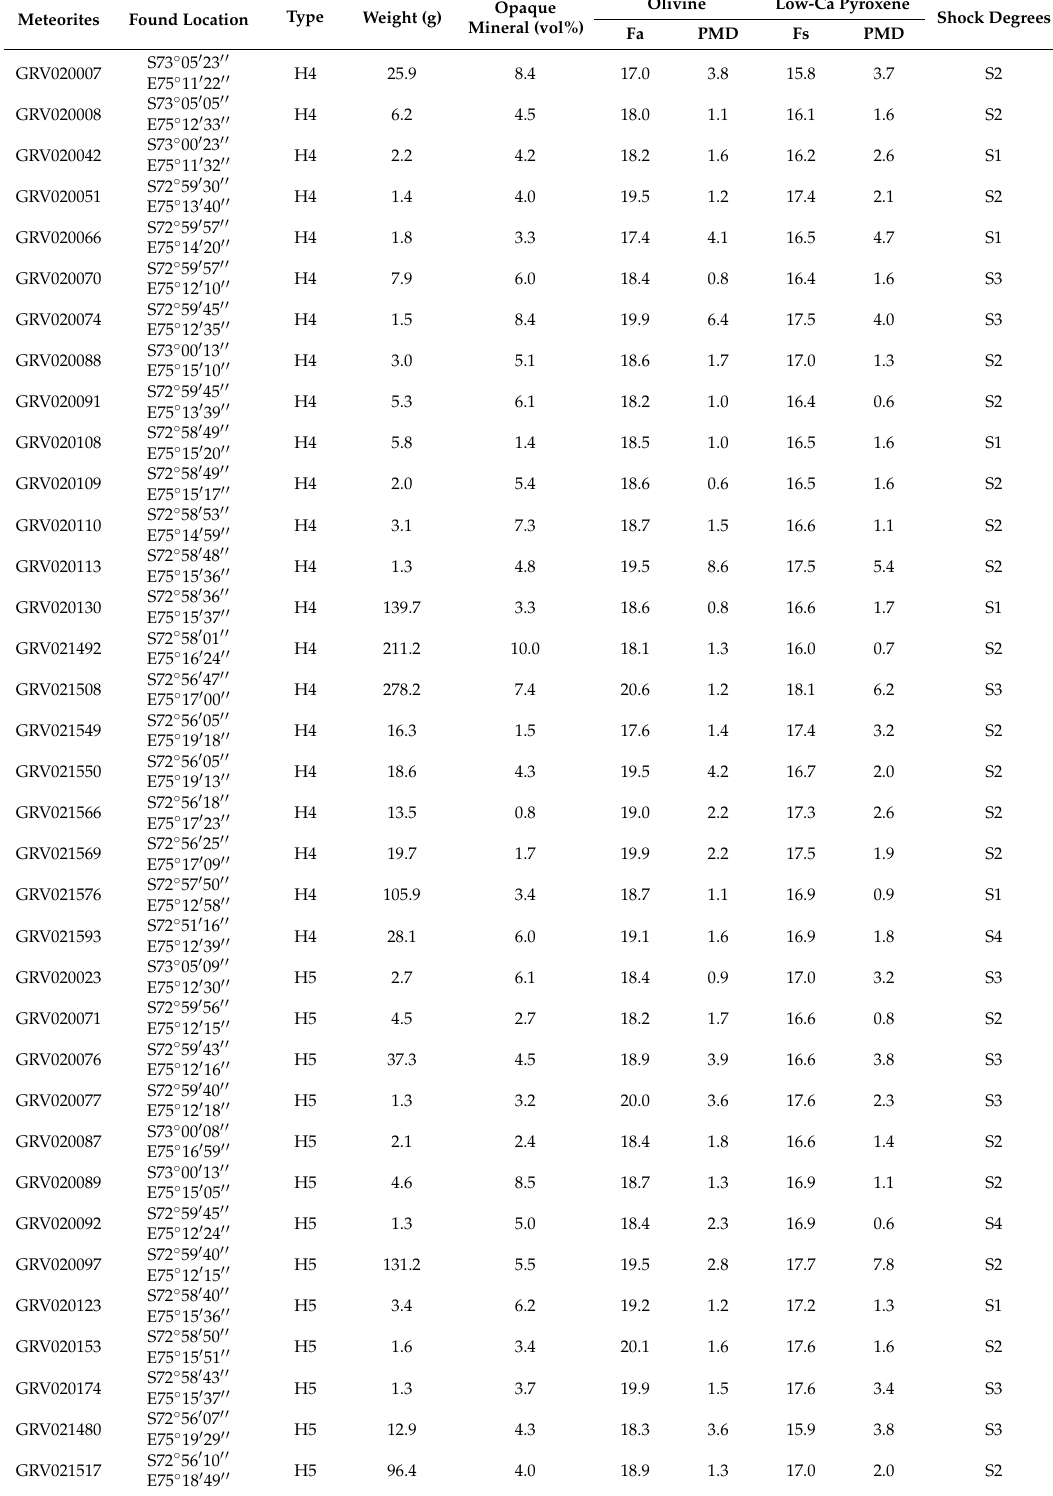
Table A1. The major characteristics of 184 ordinary